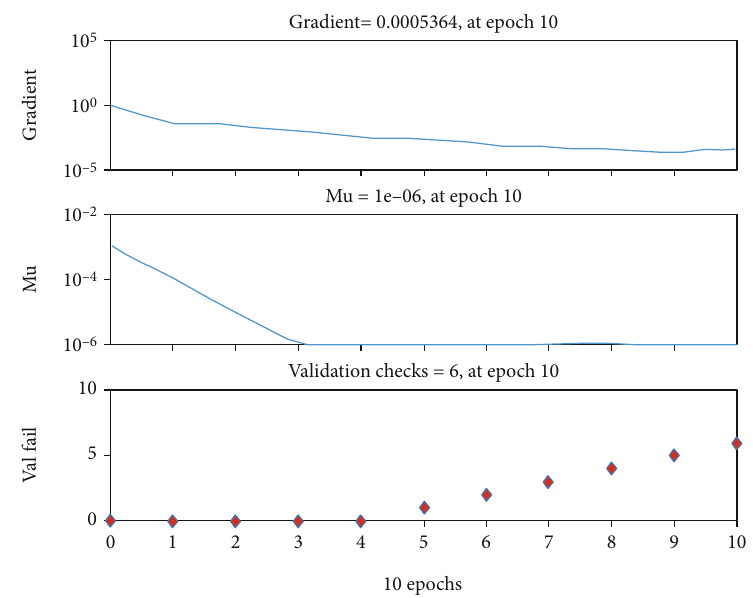
Figure 5: Training state